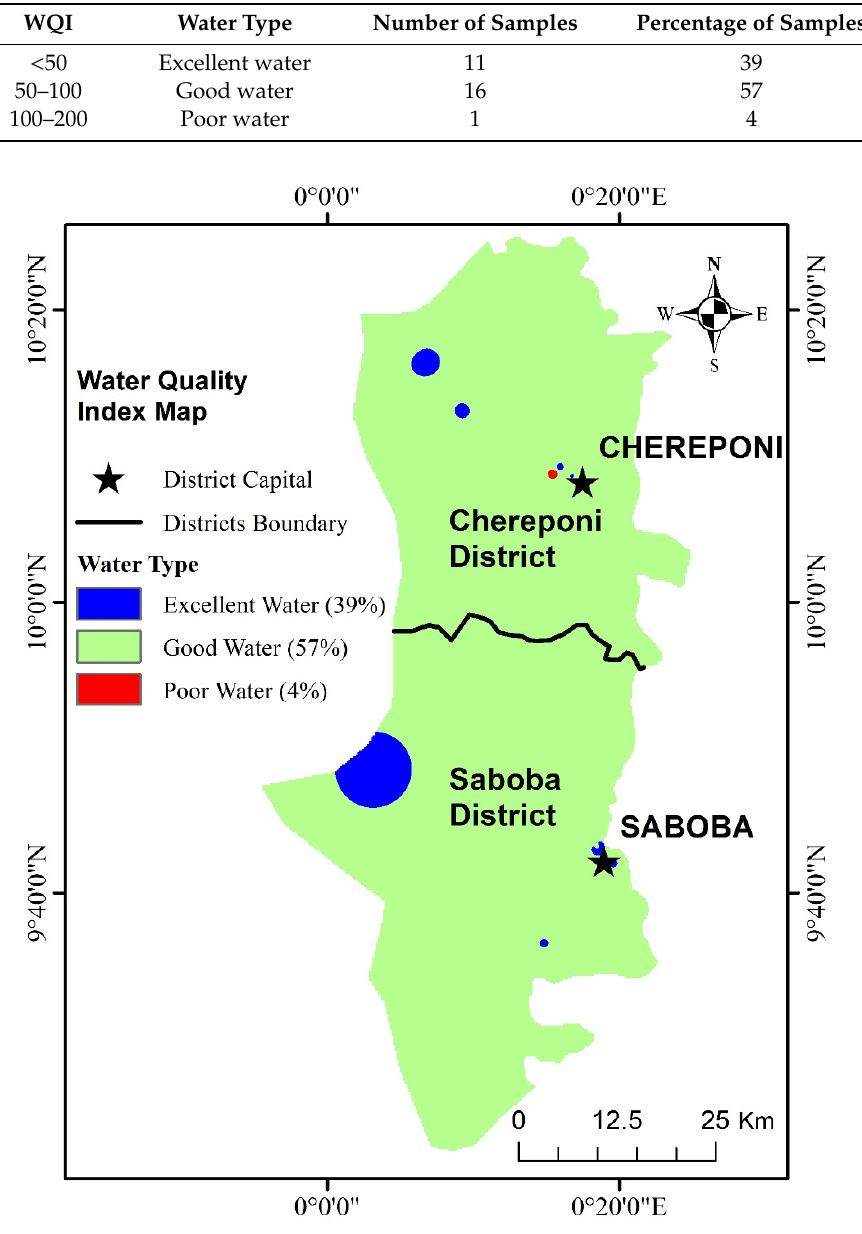
Table 6. Classification of groundwater quality based on WQI.